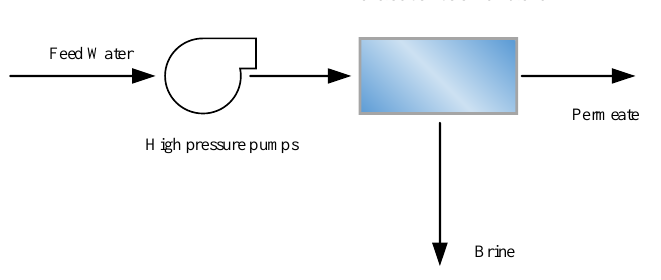
Fig. 3. Diagram of a reverse osmosis